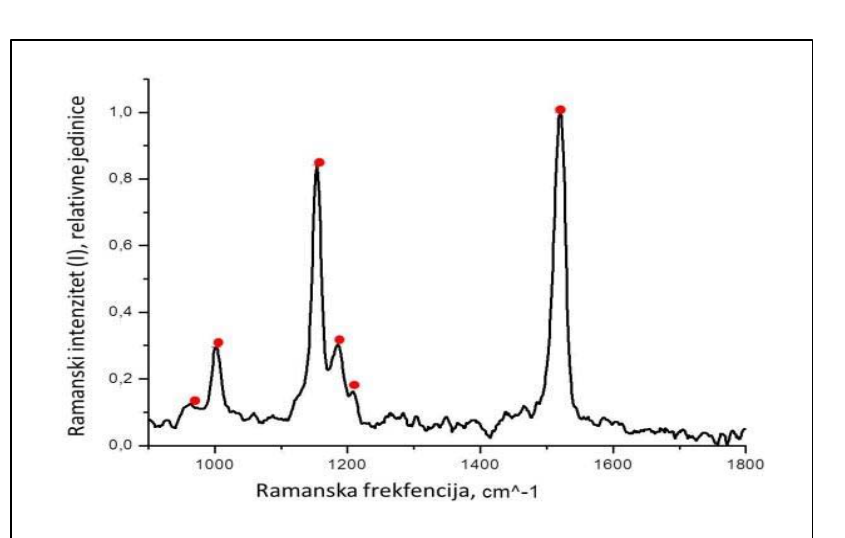
Figure 2 – Resonance Raman spectrum of the leaf of the maize inbred lines ZPPL 146 and ZPPL